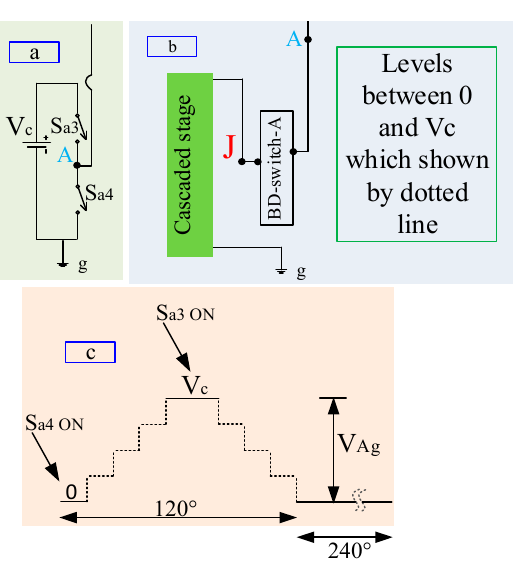
Figure 2. Simplified structure of the proposed CMLI, ( a ) generation of maximum and zero voltage levels; ( b ) intermediate level generation; ( c ) pole voltage waveform. Reprint with permission